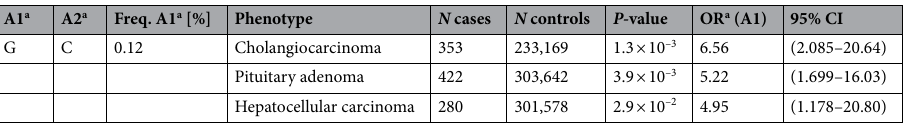
Table 1. Association analysis of rs146589465-G. Shown are associations for rs146589465-G in the Icelandic cohort that reached a threshold of P -value less than 5.0 × 10 –2 . The variant results in coding change p.D522E in ATG7. a A1 and A2 stand for the two alleles tested for the marker. Odds-ratio (OR) and population allele frequency (Freq. A1) are provided for allele